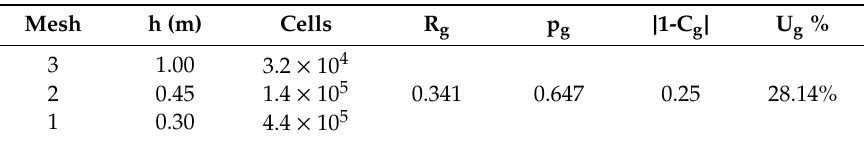
Figure 7. Mesh independence analysis. ( a ) Angular acceleration vs. time, and size independence. ( b ) Angular acceleration vs. time, and time independence. Table 1. Mesh independence analysis.